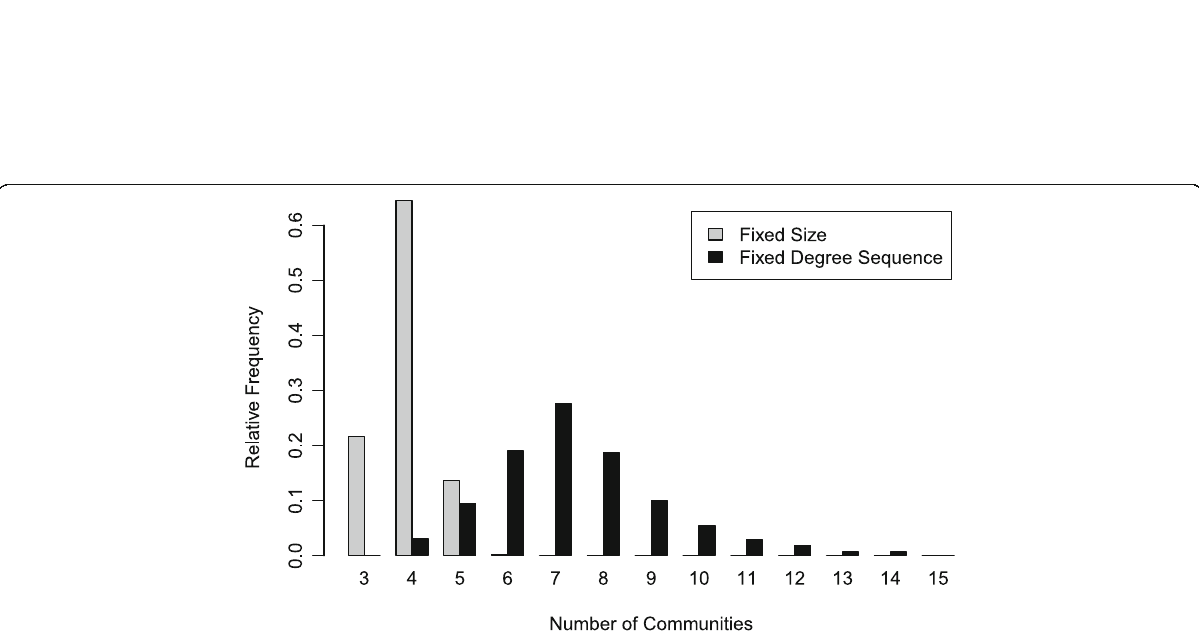
Fig. 4 Monte-Carlo simulations: Number of detected communities by the random graph